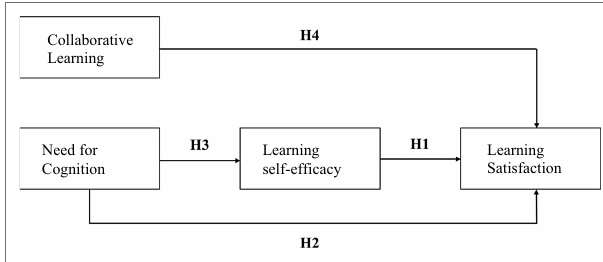
FIGURE 2 | Research